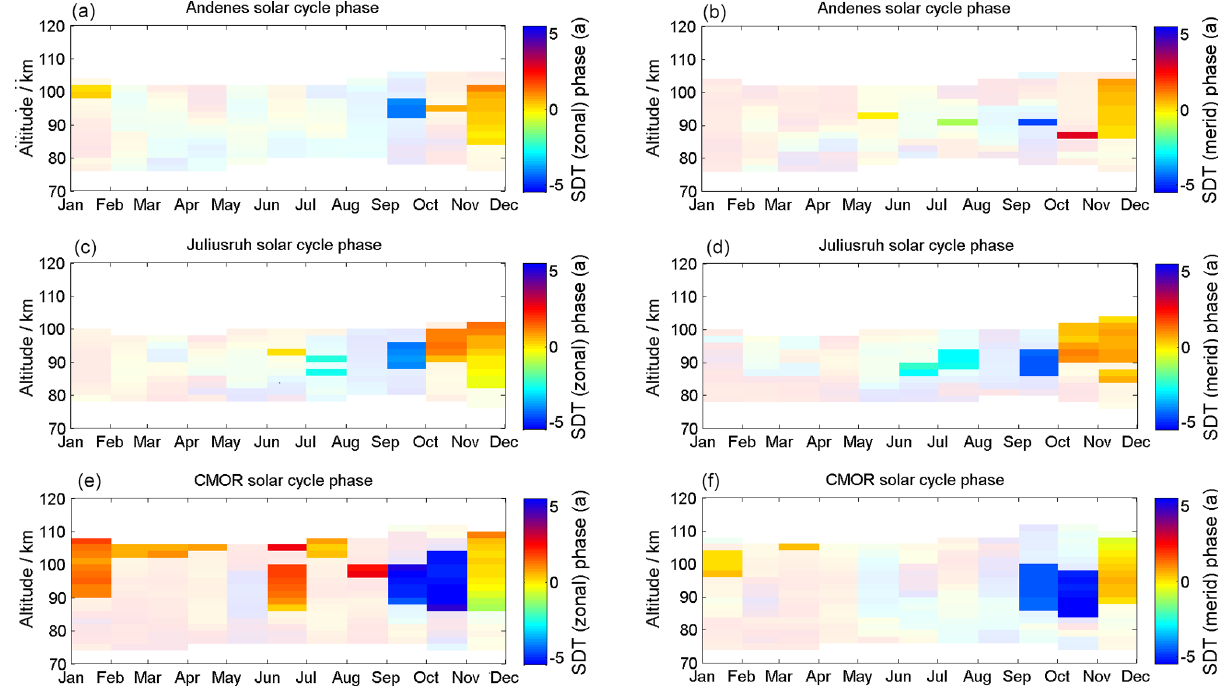
Figure A3. Same as Fig. A1 but for the semidiurnal